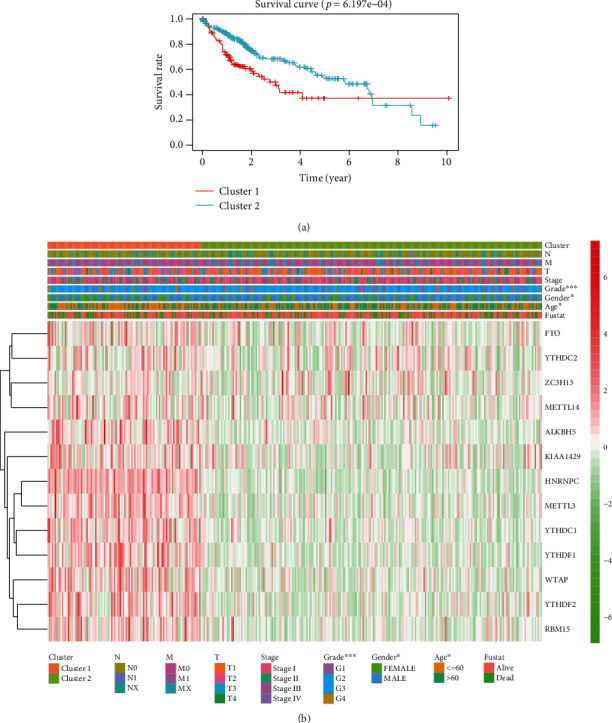
Differential clinicopathological features and overall survival of hepatocellular carcinoma in the cluster 1/2 subgroups. (a) The Kaplan–Meier overall survival (OS) curves for 374 TCGA hepatocellular carcinoma patients. Gastric cancer patients in the cluster 1 subgroup are marked with red, and those in the cluster 2 subgroup are marked with blue. (b) Heatmap and clinicopathologic features of the two clusters defined by the m6A RNA methylation regulators consensus expression (red is upregulated and green is downregulated; ∗p < 0.05, ∗∗p < 0.01, and ∗∗∗p < 0.001).